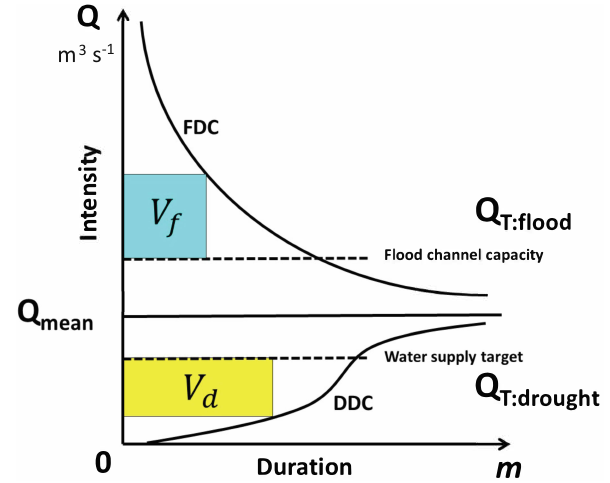
Figure 6. Schematic illustration of how to calculate necessary stor- ages V f and V d to smooth out the hydrological variation to 3 Q mean for flood control and 0.5 Q mean for drought